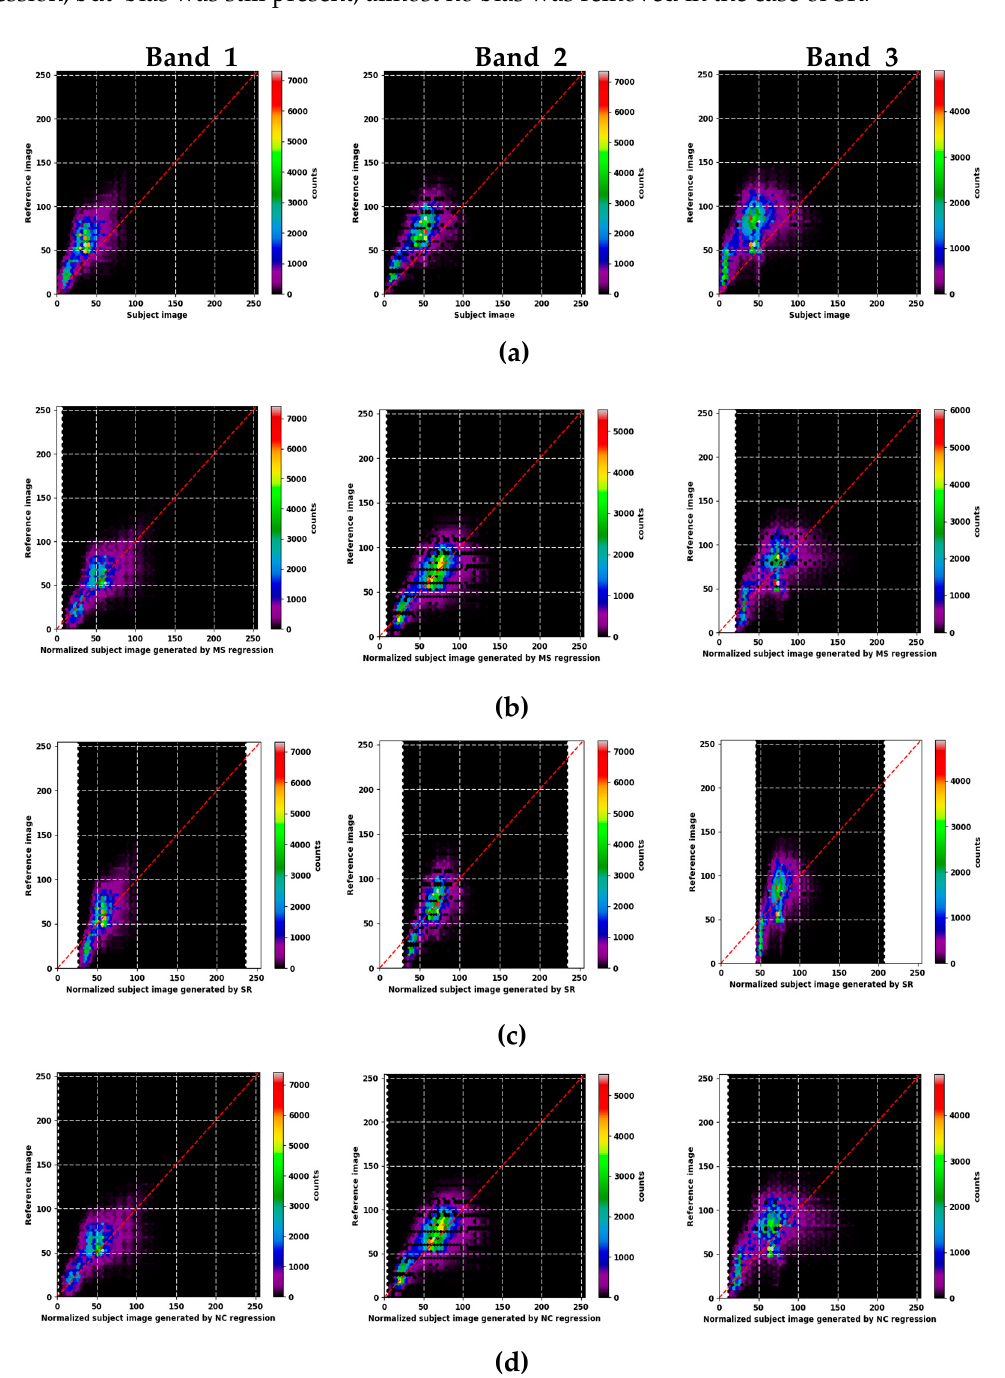
Figure 4. Scattergram of Band 1, Band 2 and Band 3 with reference image: ( a ) raw subject image; ( b ) normalized subject image generated by MS regression; ( c ) normalized subject image generated by SR; and ( d ) normalized subject image by NC regression.